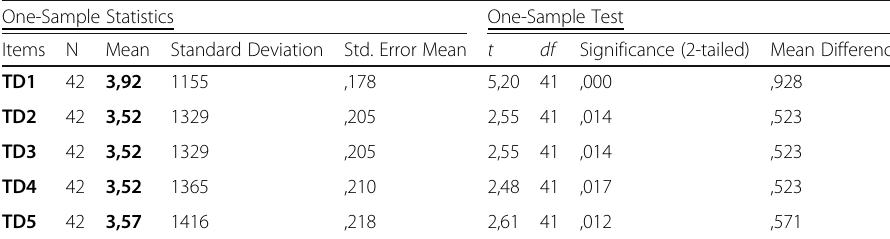
Table 7 One sample t -test for Technical Dimensions One-Sample